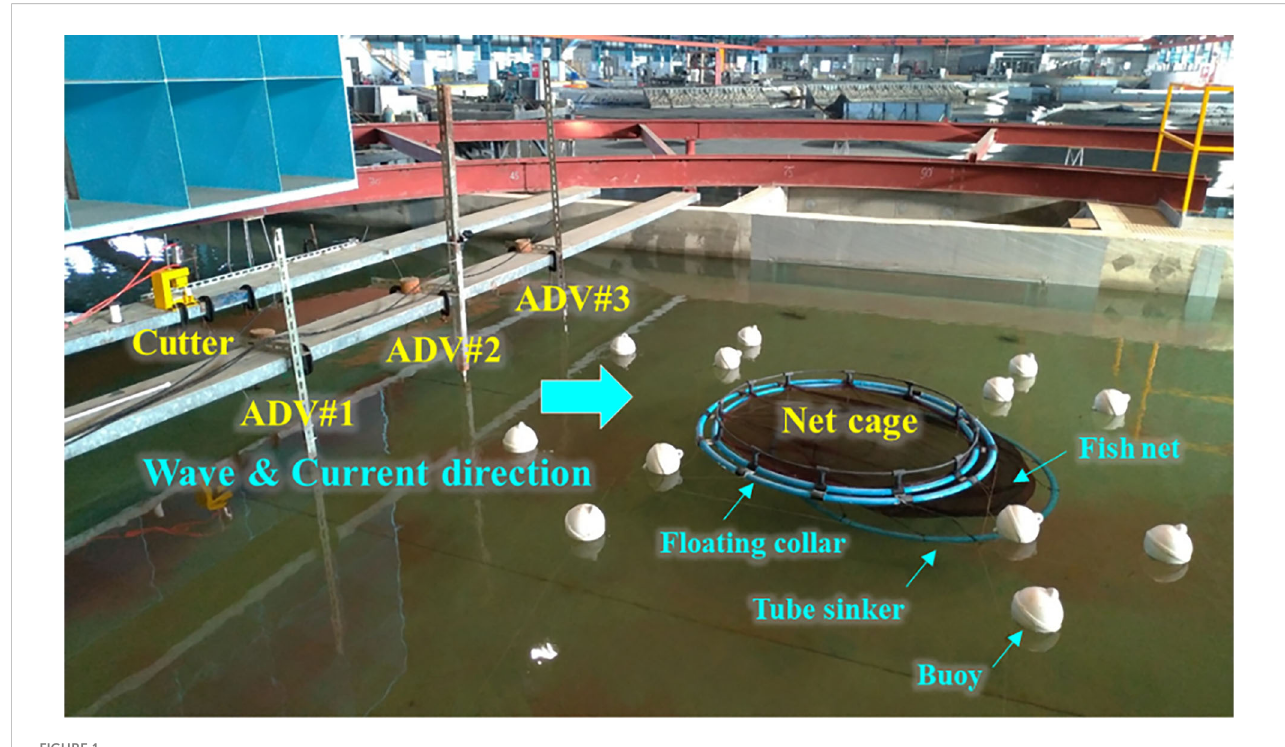
FIGURE 1 Photo of the net cage model installed in a wave